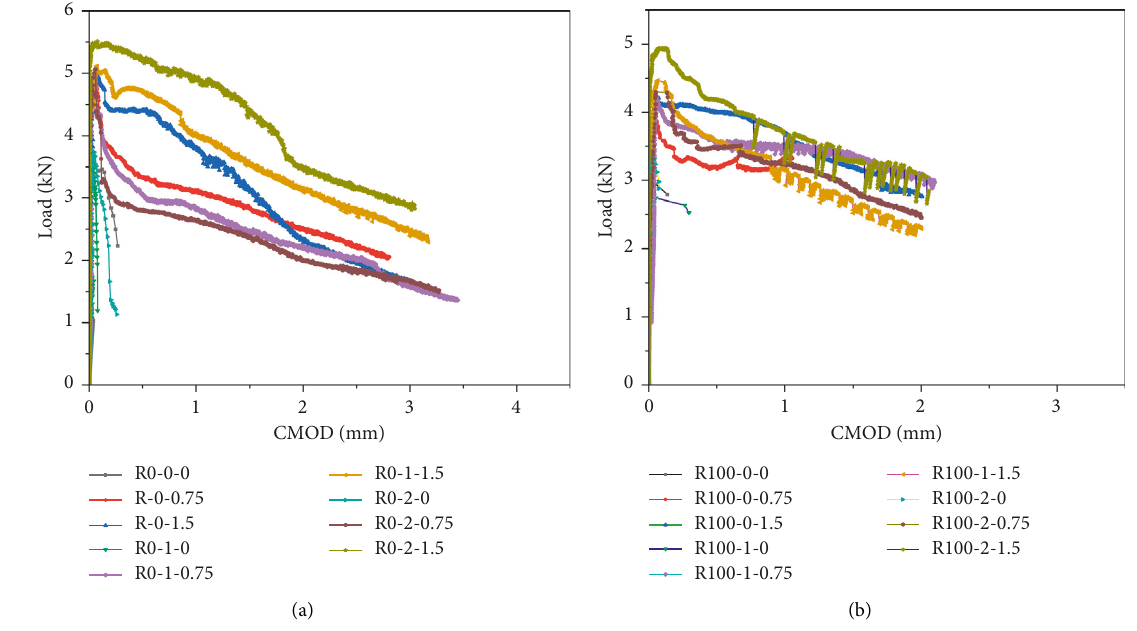
Figure 7: P-CMOD curve. (a) Replacement rate of 0%. (b) Replacement rate of